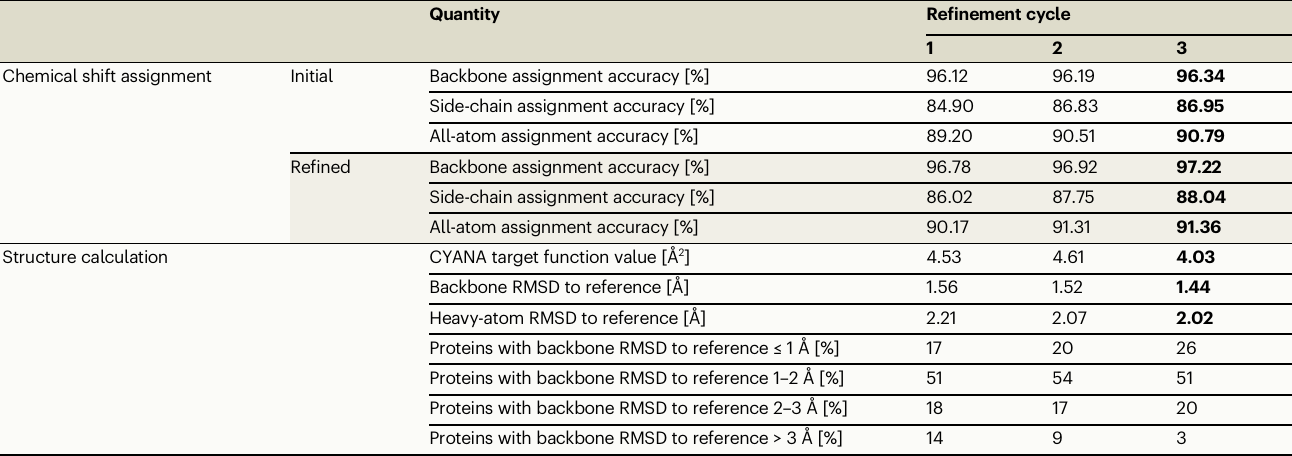
Table 1 | Quality of assignments and structures in each re fi nement cycle Quantity Re fi nement